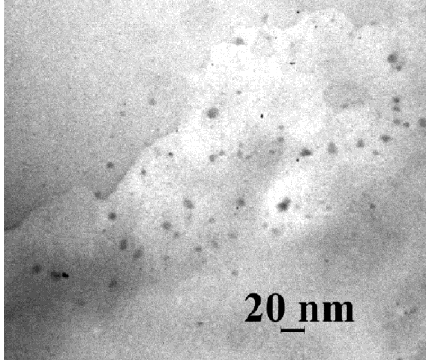
Figure 3. TEM image of the Co-Im/SiO 2 composite.